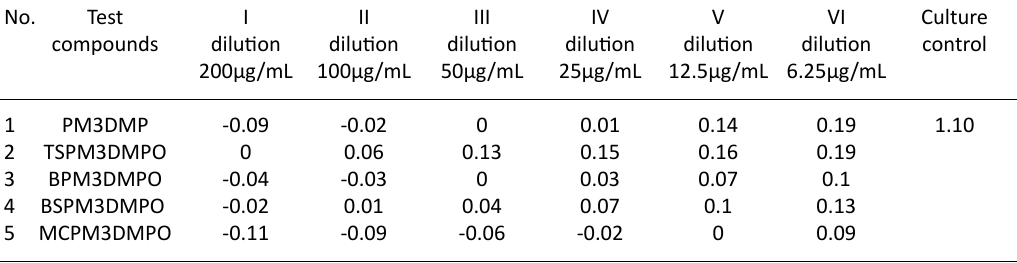
Table 9. MIC of Piperidines against Proteus sp. at 600 nm No.